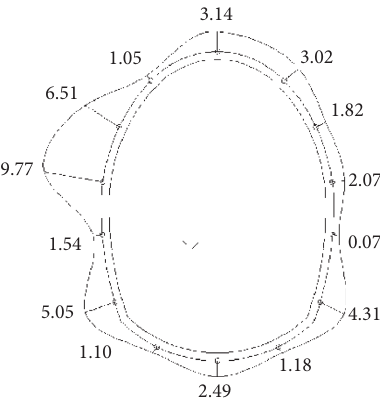
Figure 15: Distribution of shotcrete stress of initial support on the cross-section C (unit: